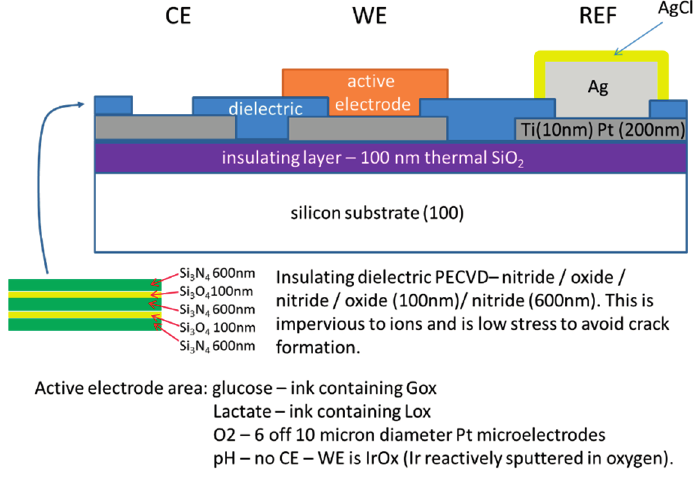
Figure 2 . Diagram illustrating cross-section (not to scale) through the MEMS-microfabricated sensor device